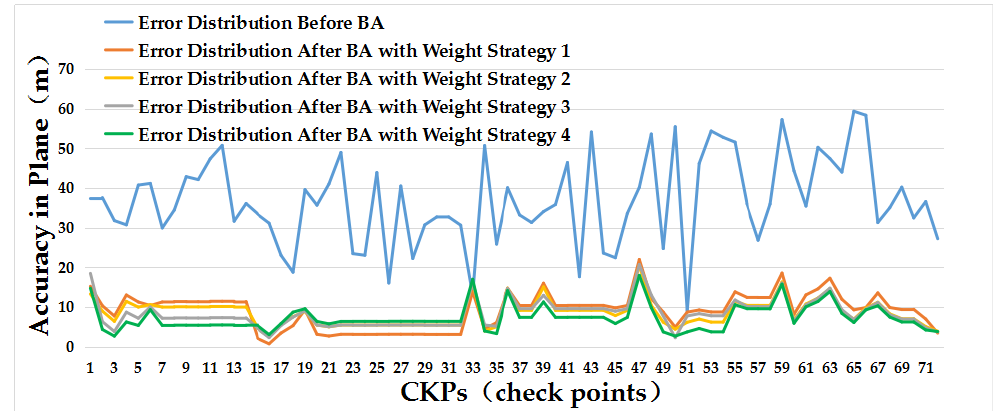
Figure 10. Plane error distribution of our test dataset. BA is the abbreviation of free block